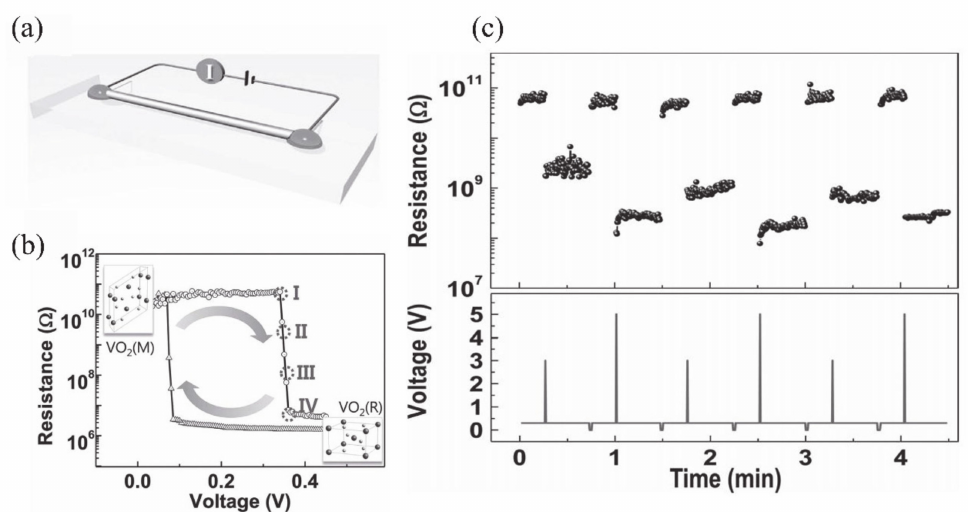
Figure 21. ( a ) A schematic of the memristor device. ( b ) The resistance–voltage (R–V) hysteresis curve. ( c ) Demonstration of the information storage. Reproduced from [10], with permission from John Wiley and Sons,